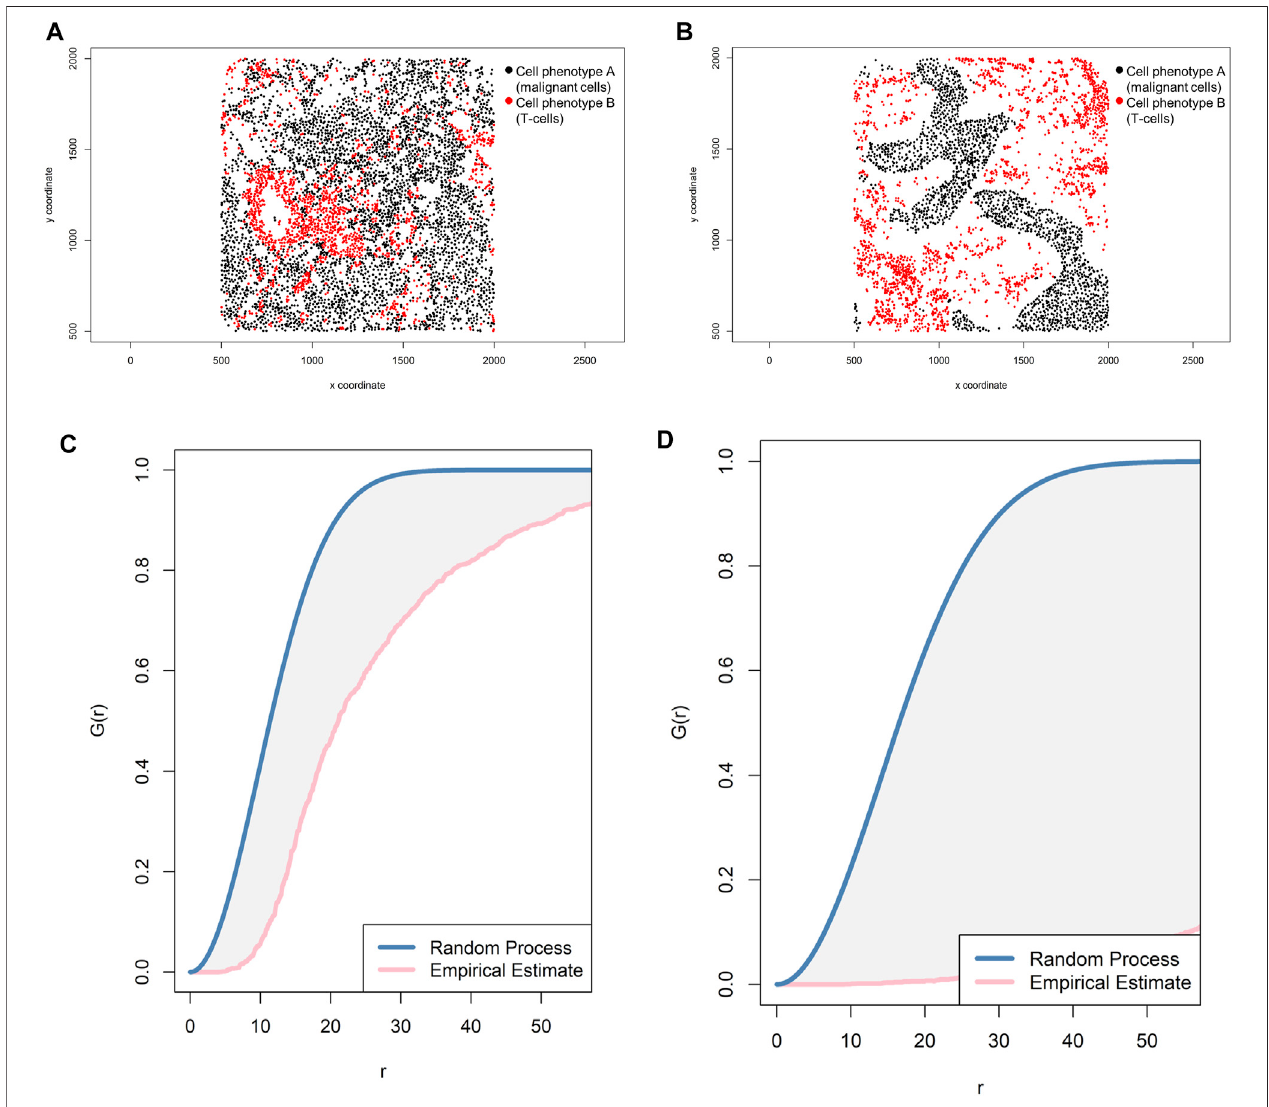
FIGURE 9 | Representative graphs showing the G-function [G( r )] curve of point pattern distributions for cell phenotype A (malignant cells) to cell phenotype B (T-cells) in a representativemultiplex immuno fl uorescence image of lung adenocarcinoma. (A) Random point pattern distribution ofcell phenotype A and B. (C) Graphic representation of the image shown in A using the cross-G-function, showing the proximity of the G( r ) curve to the theoretical estimate curve (Poisson curve), characterizing a random or mixed cell distribution pattern of one cell population in relation to another cell population. (B) Unmixed point pattern distribution of cell phenotypeAandB. (D) GraphicrepresentationoftheimageshowninBusingthecross-G-function,showingtheincreaseddistanceoftheG( r )curvefromthetheoretical estimate curve (Poisson curve), characterizing a clustering or unmixed cell distribution pattern of one cell population in relation to another cell population. The graphics were generated using R studio software version